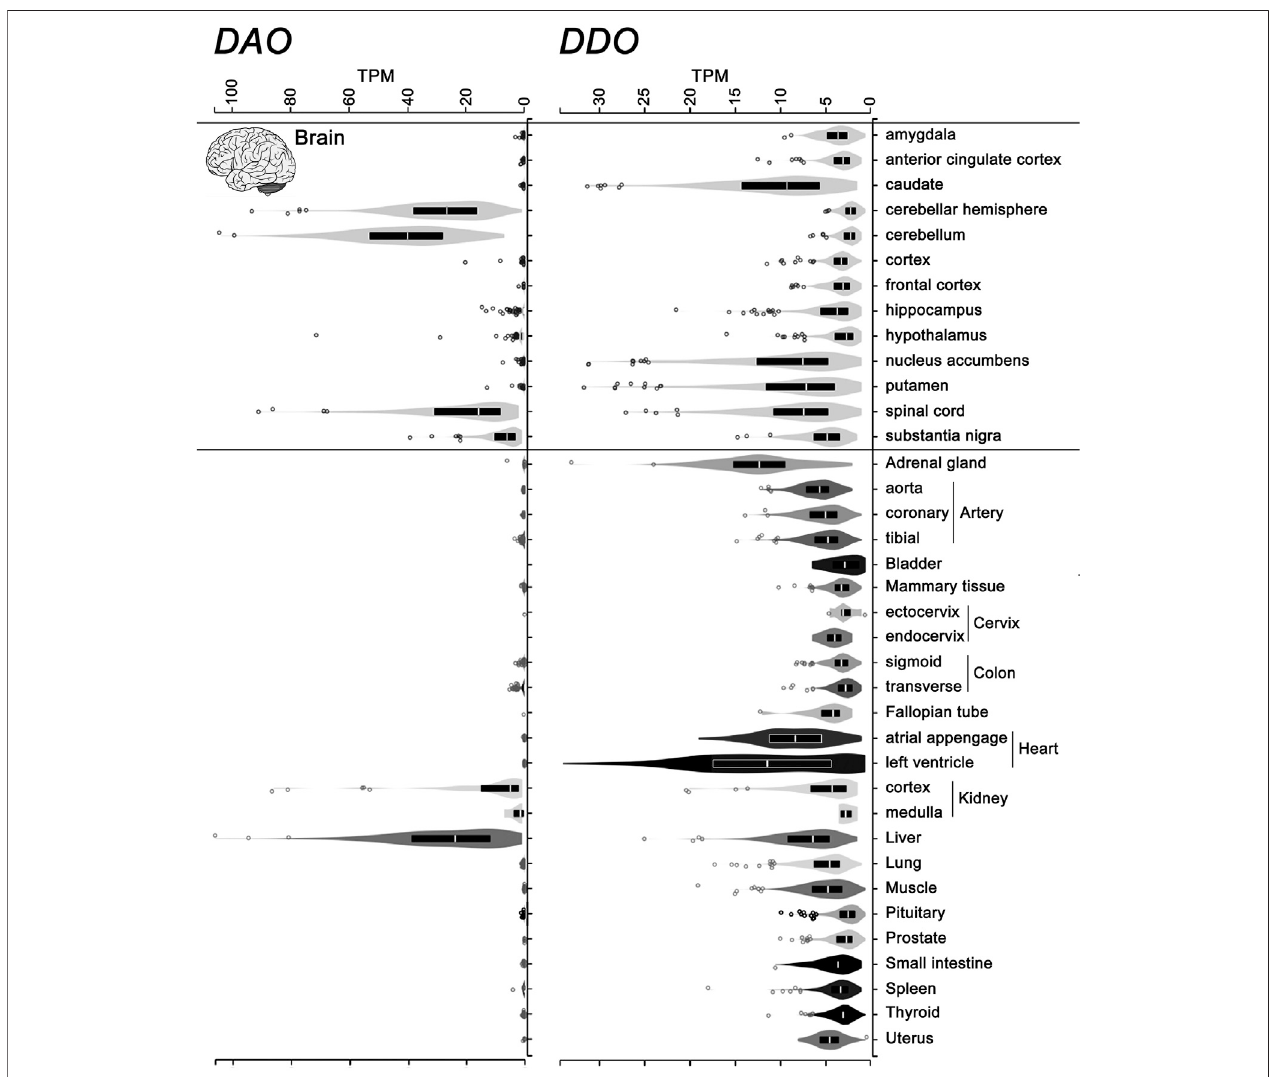
FIGURE 6 | Levels of the transcripts encoding hDASPO and hDAAO in human tissues. Violin plot representing DDO (ENSG00000203797.9) and DAO (ENSG00000110887.7)genetranscriptlevelsindifferenthumantissues.DatawereobtainedfromtheGenotype-TissueExpression(GTex)ProjectPortal,GTExAnalysis ReleaseV8(dbGaPAccessionphs000424.v8.p2,www.gtexportal.org).ValuesareshowninTPM(transcriptsperkilobasemillion);tissuesinwhich DDO transcriptvalues werelowerthan 2 TPMwereomitted.Boxplotsrepresent themedian and25thand75thpercentiles.Dotsaredatapointsabove orbelow1.5-foldtheinterquartile range, displayed as